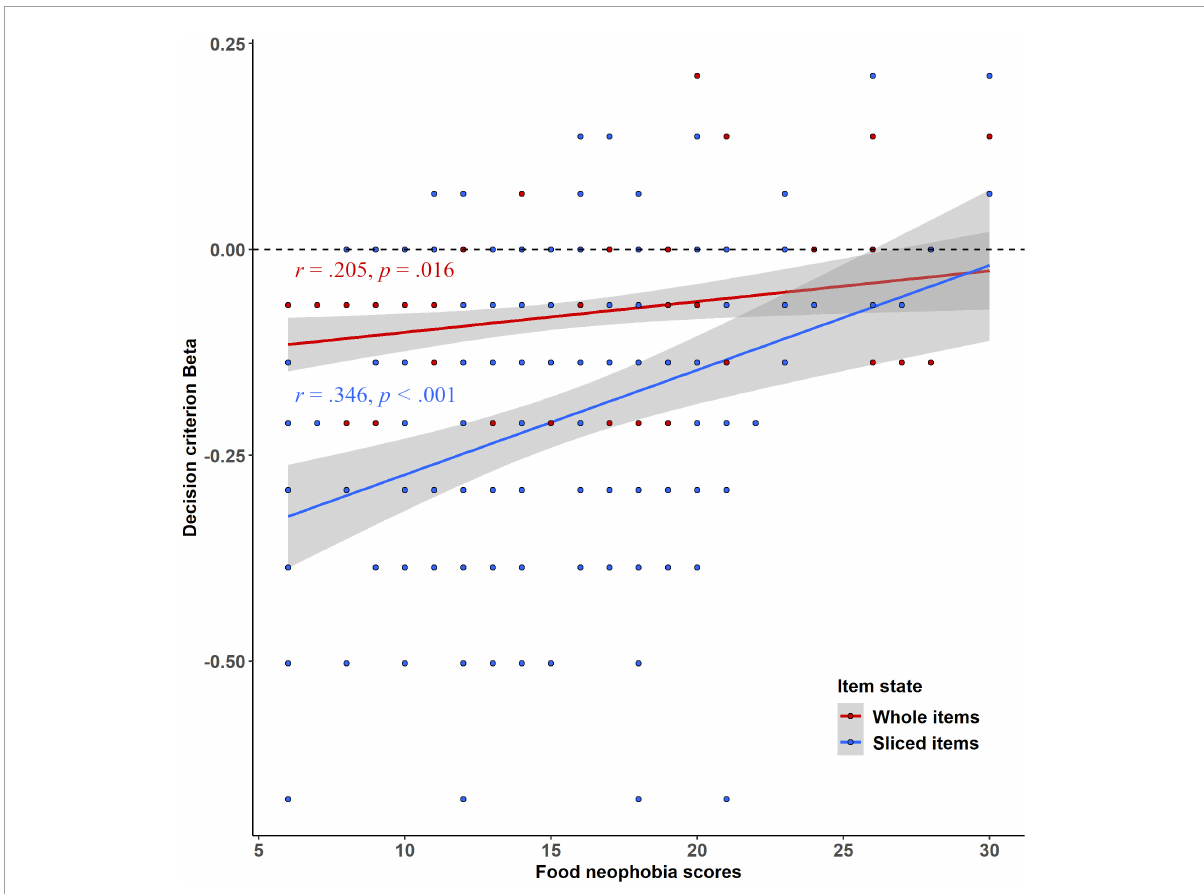
FIGURE3 Children’s decision criterion scores Beta as a function of their food neophobia scores and item state. The Pearson coefficient correlation indicated significant and positive correlations between the children’s food neophobia scores and decision criterion Beta, for whole ( r = 0.205, p = 0.016, the red line) and sliced items ( r = 0.346, p < 0.001, the blue